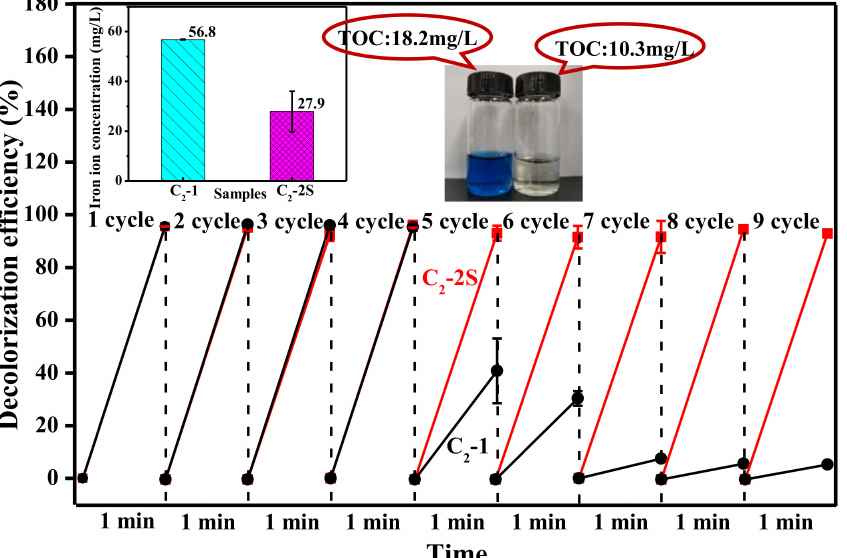
Figure 8. Decolorization efficiency in the process of reusing the fibers C 2 -1 and C 2 -2S to decolorize fresh MB aqueous solution; the fibers C 2 -1 and C 2 -2S are defined in Section 2.4; the graph inset in the upper left corner shows the average concentration of iron ions eluted into the MB aqueous solutions obtained during the first three cycles; the picture inset in the upper right corner represents the TOC values of fresh MB aqueous solution and MB aqueous solution obtained at a treatment time of 1 min during the ninth cycle of fiber C 2